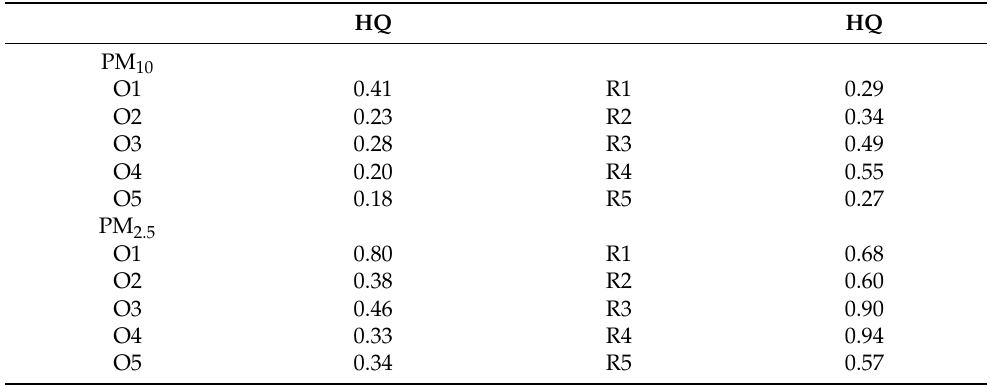
Table 3. Hazard quotients of PM 10 and PM 2.5 during outdoor (O) and realistic (R) exposure scenar- ios.